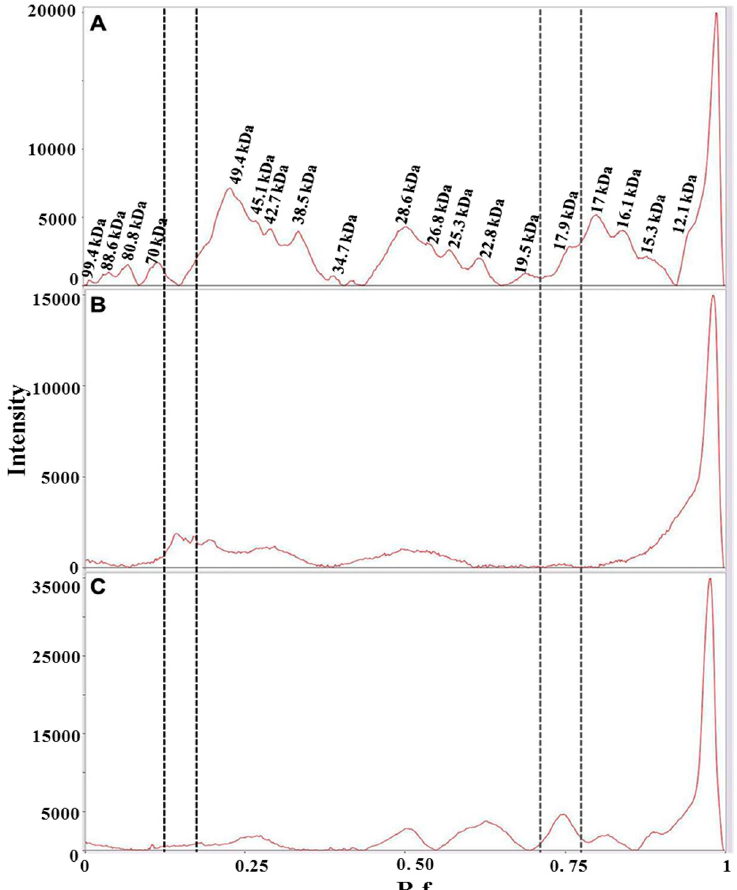
Figure 6. Bands detected in 1D-SDS-PAGE of two months aged dried stigmas and styles from Spain ( A ); dried petals of Carthamus tinctorius ( B ) and dried fruits of Gardenia jasminoides ( C ) . Gel image was acquired with ChemiDoc™ MP System imager and analyzed with Image Lab software (version 5.2). Vertical lines bracket bands that are uniquely present in either Carthamus tinctorius L. (black dotted lines) or Gardenia jasminoides (gray dotted lines) .